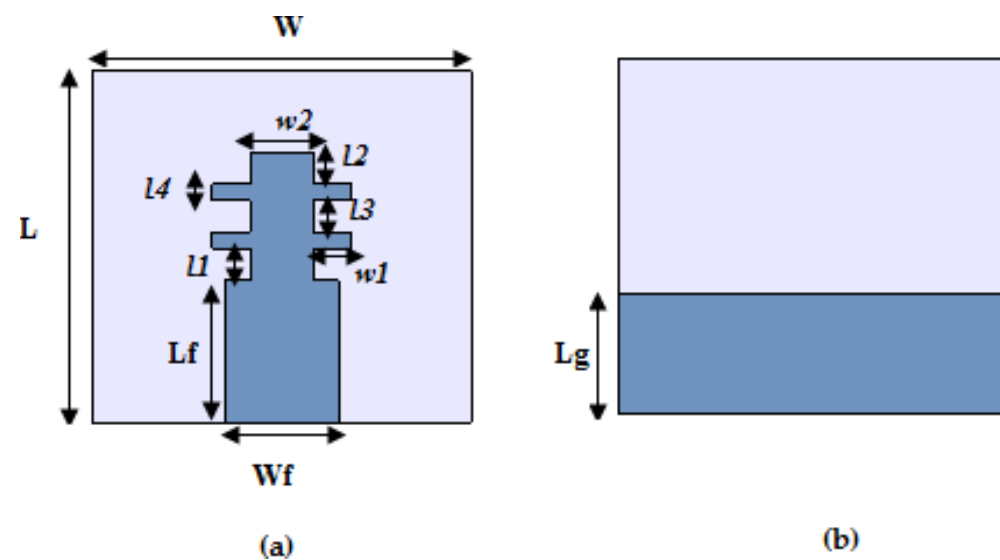
Figure 1. Geometry of proposed transparent antenna. ( a ) Front view; ( b ) rear view. Table 2. Dimensions of the proposed antenna. Parameters Dimension (in